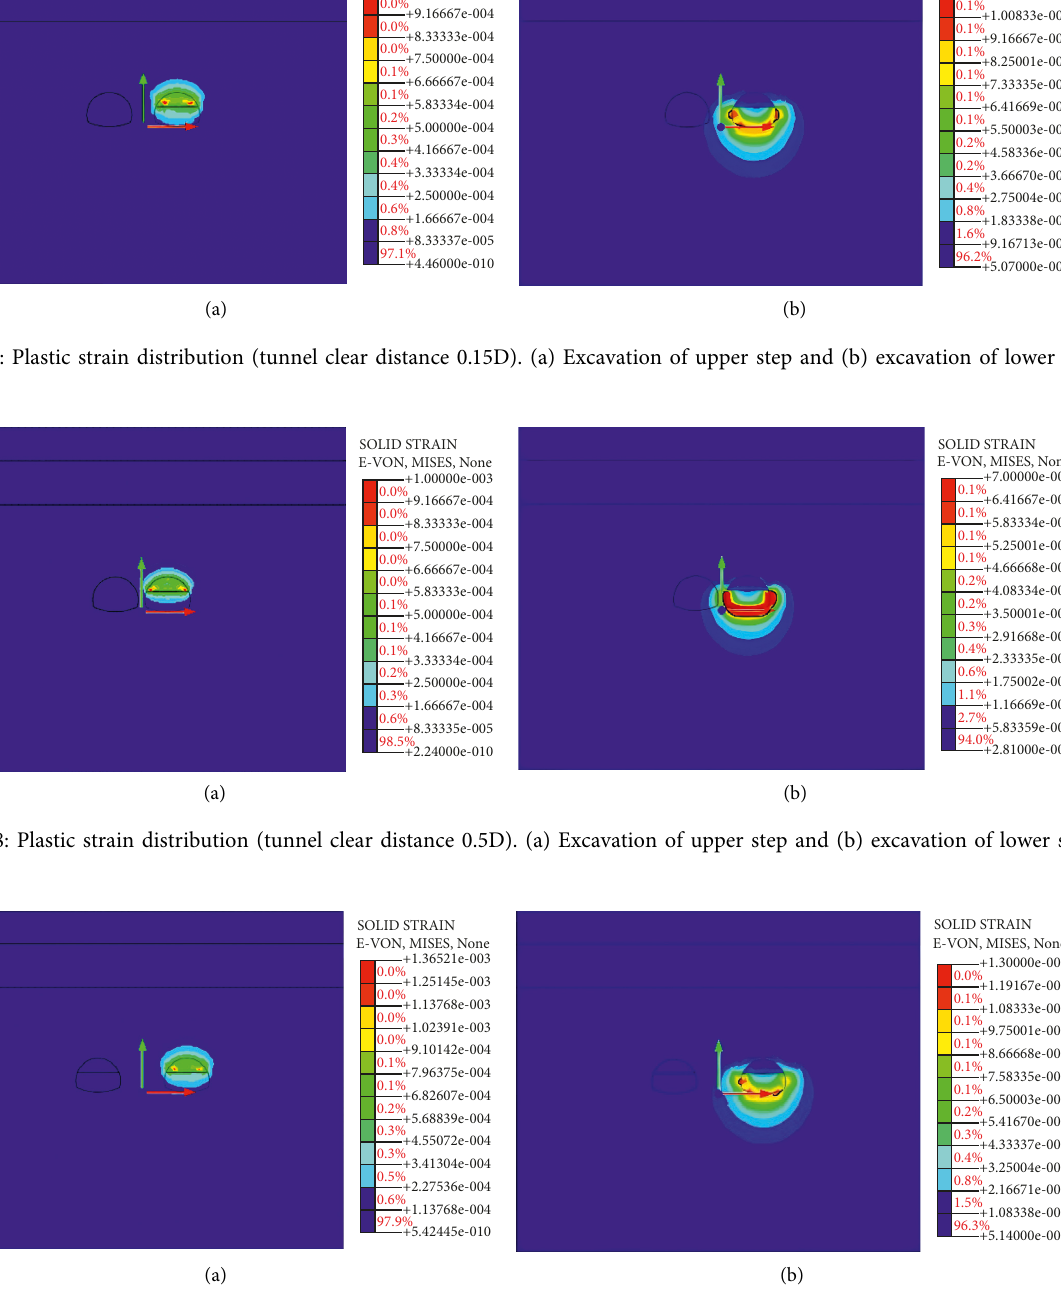
Figure 19: Plastic strain distribution (tunnel clear distance D). (a) Excavation of upper step and (b) excavation of lower step.